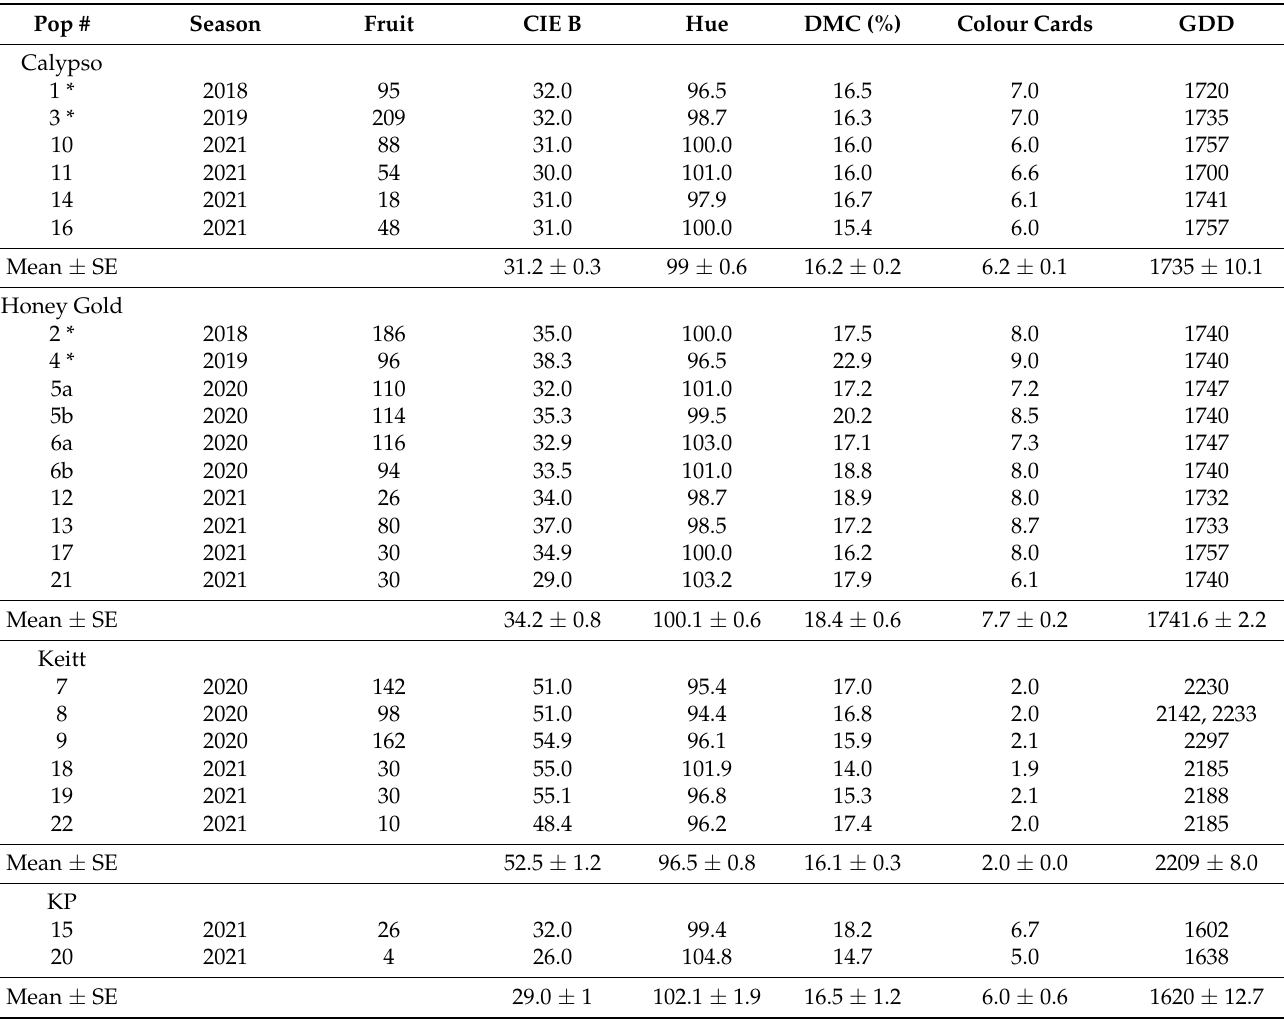
Table 10. GDD validation exercise: Maturity attributes of fruit 2021/22 season harvested close to a GDD of 1728, 1740, 2185, and 1600 for Calypso, Honey Gold, Keitt and KP populations, respectively. Population numbers refer to Table